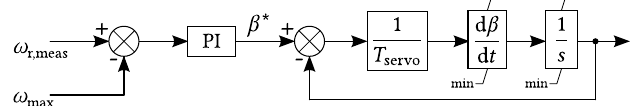
Figure 18. Traditional pitch